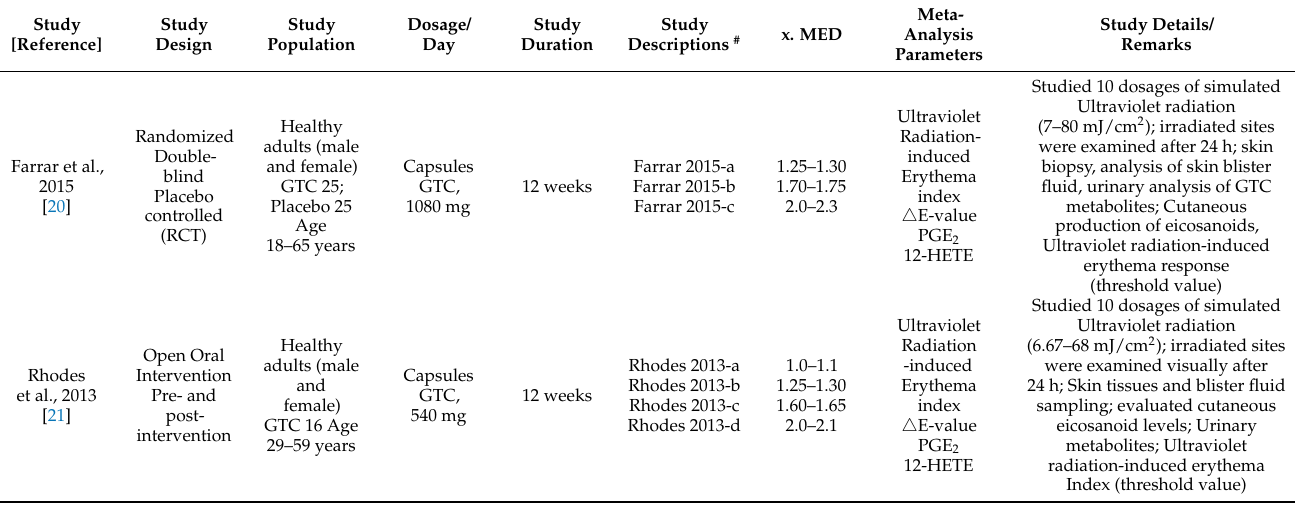
Figure 2. Schematic PRISMA flow diagram of included and excluded studies retrieved and identified by individual searches, and evaluated in the systematic review and meta-analysis of the effect of green tea catechins on the ultraviolet irradiation-induced erythema response. Table 1. Characteristics features and methodological assessments of the included studies evaluated in the meta-analysis of green tea catechin’s effect on ultraviolet irradiation-induced erythema response in healthy